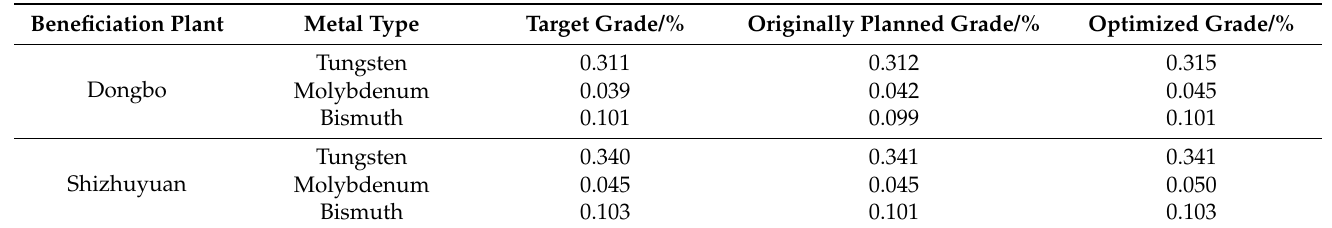
Table 7. The comparison of the grades of the three kinds of ores before and after optimization.